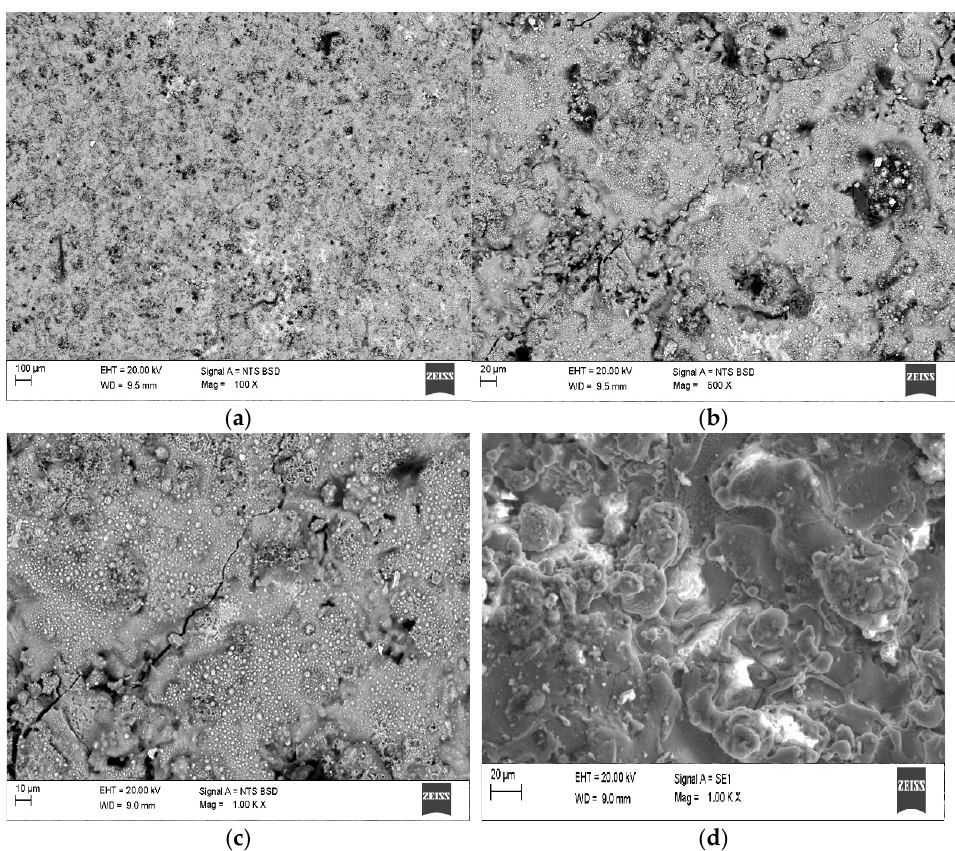
Figure 2. Morphology of coated EN8 after ( a ) 24 h, ( b ) 48 h, ( c ) 100 h hot oxidation, and ( d ) uncoated EN8 after 100 h hot oxidation (1050 °C).